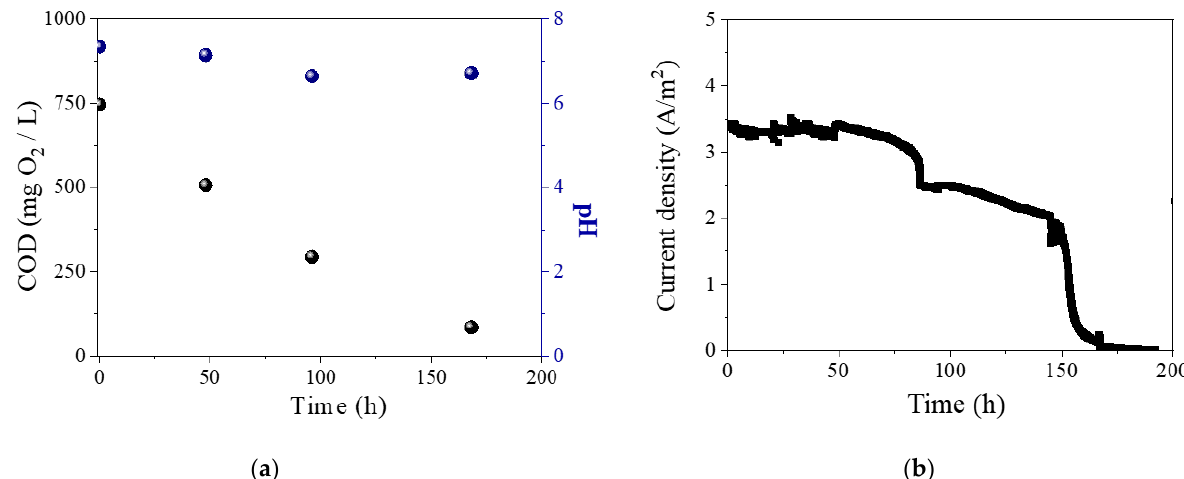
Figure 6. ( a ) COD, pH of the anolyte, and ( b ) current density (normalized to the anodic surface, 2 × 2 cm 2 ) for MEC1 vs. operation time, for the DF effluent feed. Applied cell potential: 0.9 V.